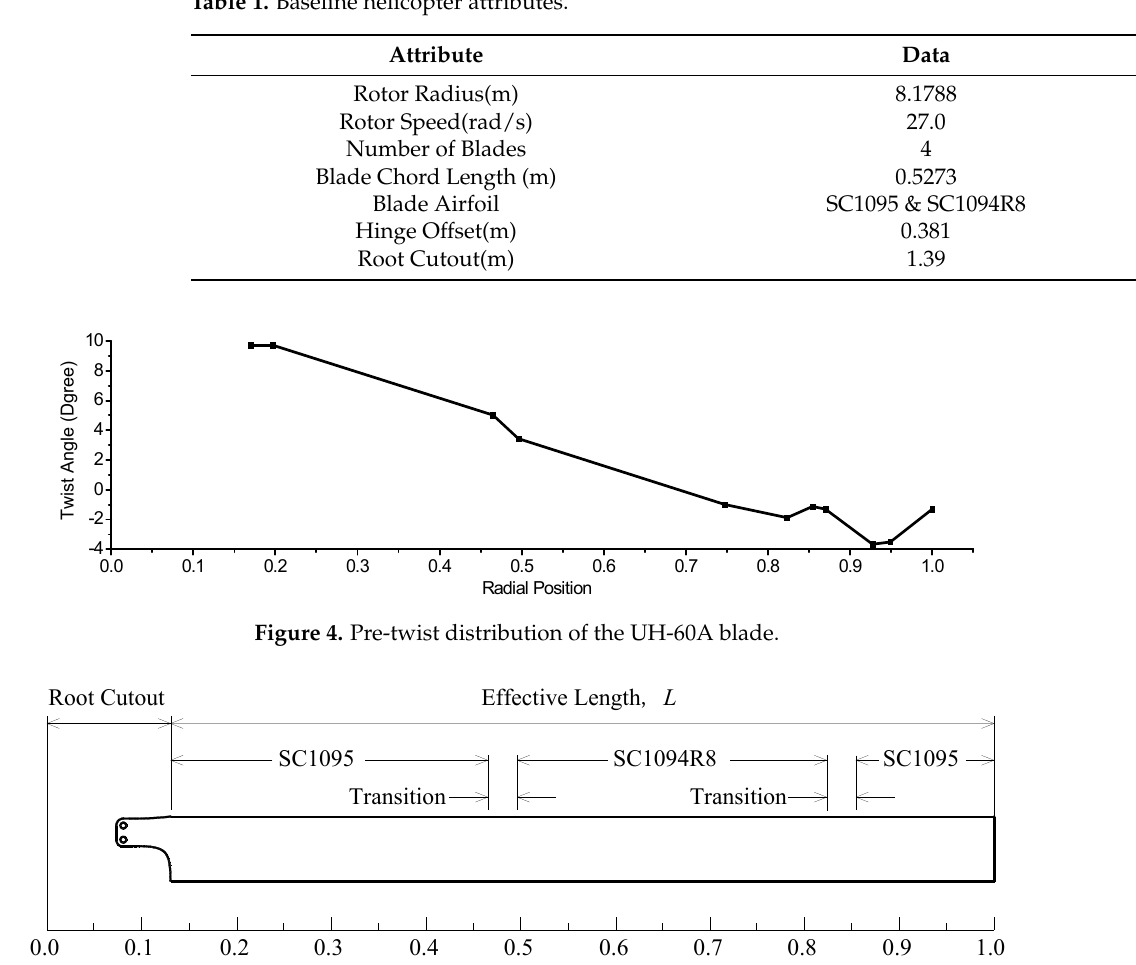
The rotor power is the product of the shaft moment and rotor speed.